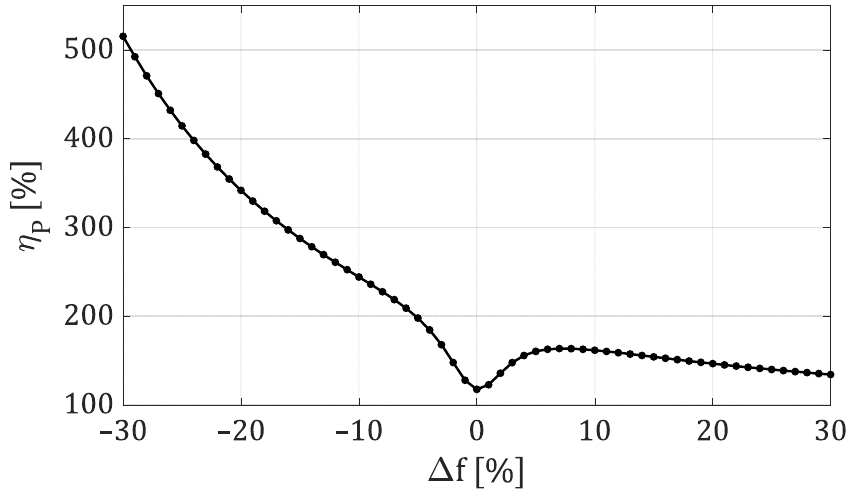
Figure 10. Power gain η P of the double coil harvester with respect to the single coil harvester, as a function of the frequency displacement from the resonance frequency ∆ f